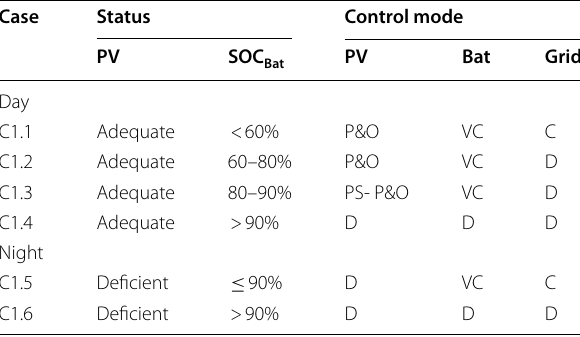
Table 1 Port state of the stop state and the control mode Case